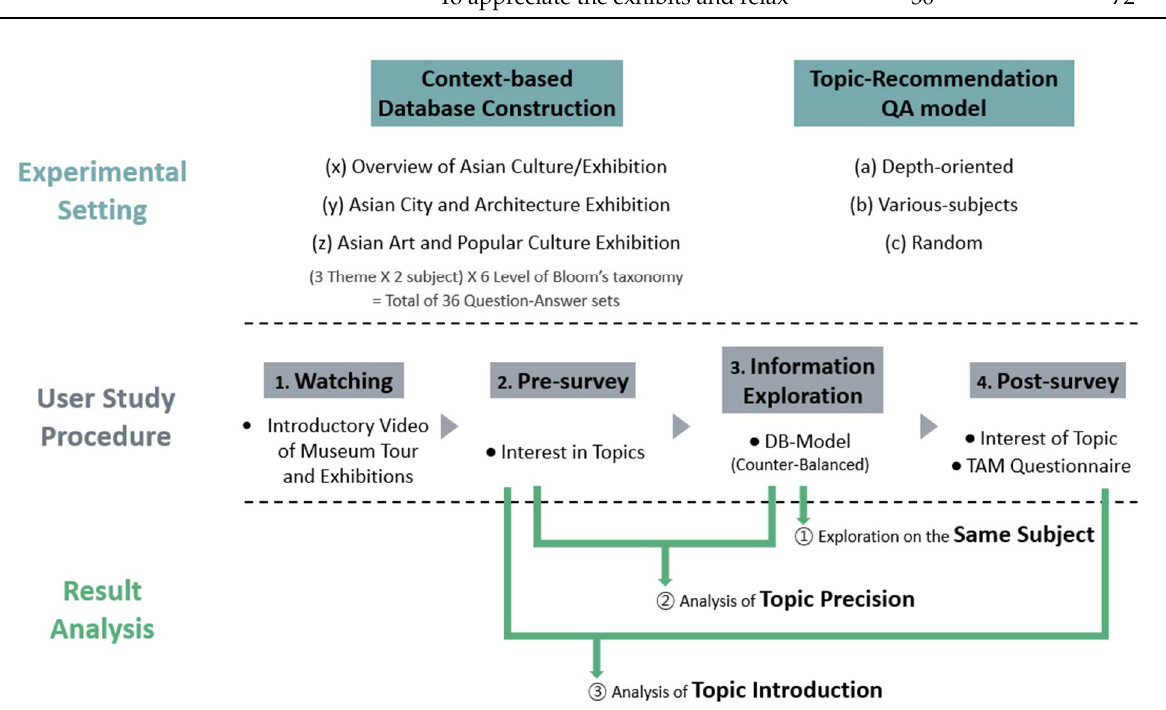
Figure 3. Experiment process flowchart.